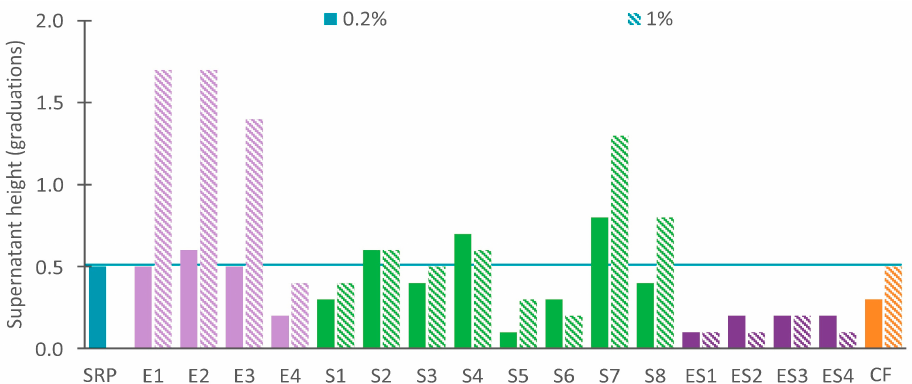
Figure 6. Supernatant height of SRP with 0.2 or 1% of dispersing agents (10 weeks at 25 °C). Refer to Tables 1–4 for dispersing agent labels.